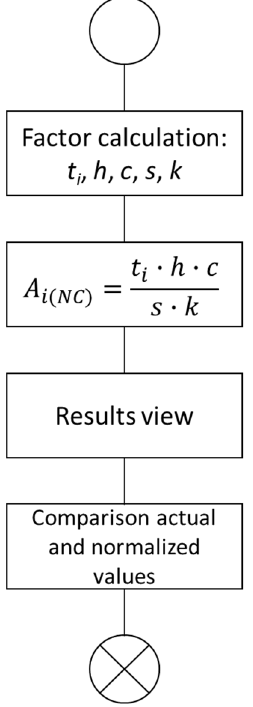
Figure 1. Block diagram of the prediction algorithm.